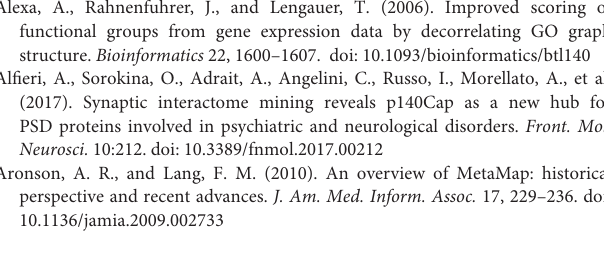
each of the genes, T- BG contain the network characteristics of the genes.